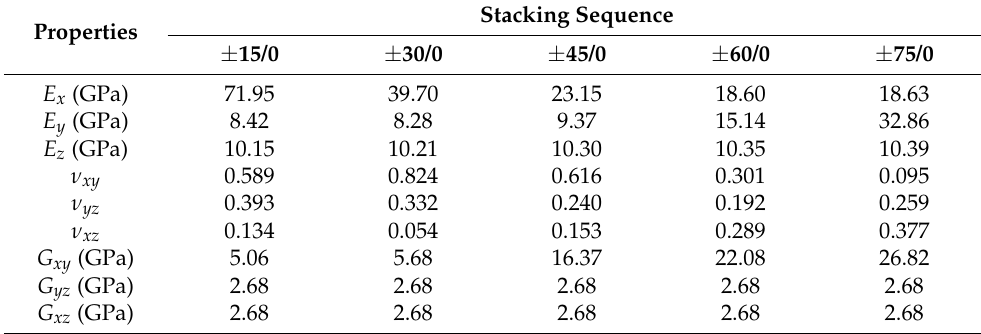
Table 11. Effective engineering constants (numerical analysis of tensile